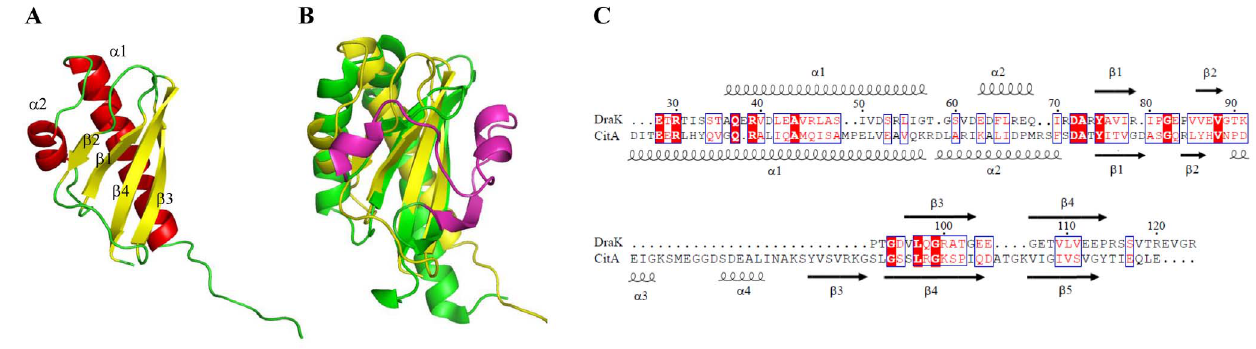
Figure 1. Solution structure of the ESD (E83Q) and sequence and secondary structure alignments with the sensor domain of CitA. ( A ) A solution structure of the ESD (E83Q) from the 20 lowest-energy structures is represented by the ribbon diagram. A helices and b strands are colored red and yellow, respectively. ( B ) The structure of the ESD (yellow) and that of the CitA sensor domain (green) are superimposed. The magenta color indicates the absent structural elements in the ESD of DraK. ( C ) Sequence alignment and comparison of the secondary structure between the sensor domain of DraK and that of CitA. The red blocks denote regions of sequence identity across the two domains, and the blue boxes indicate partially conserved residues. doi:10.1371/journal.pone.0107168.g001 of the E107 residue, the carboxyl groups of all of the glutamate and aspartate side chains are exposed to solvent, which otherwise form salt bridges with arginine side chains. In contrast, the